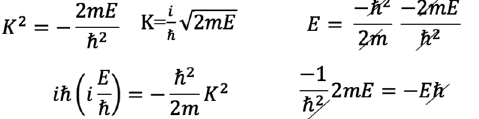
FIG. 3. Diagram of students ’ solution in algorithmic math